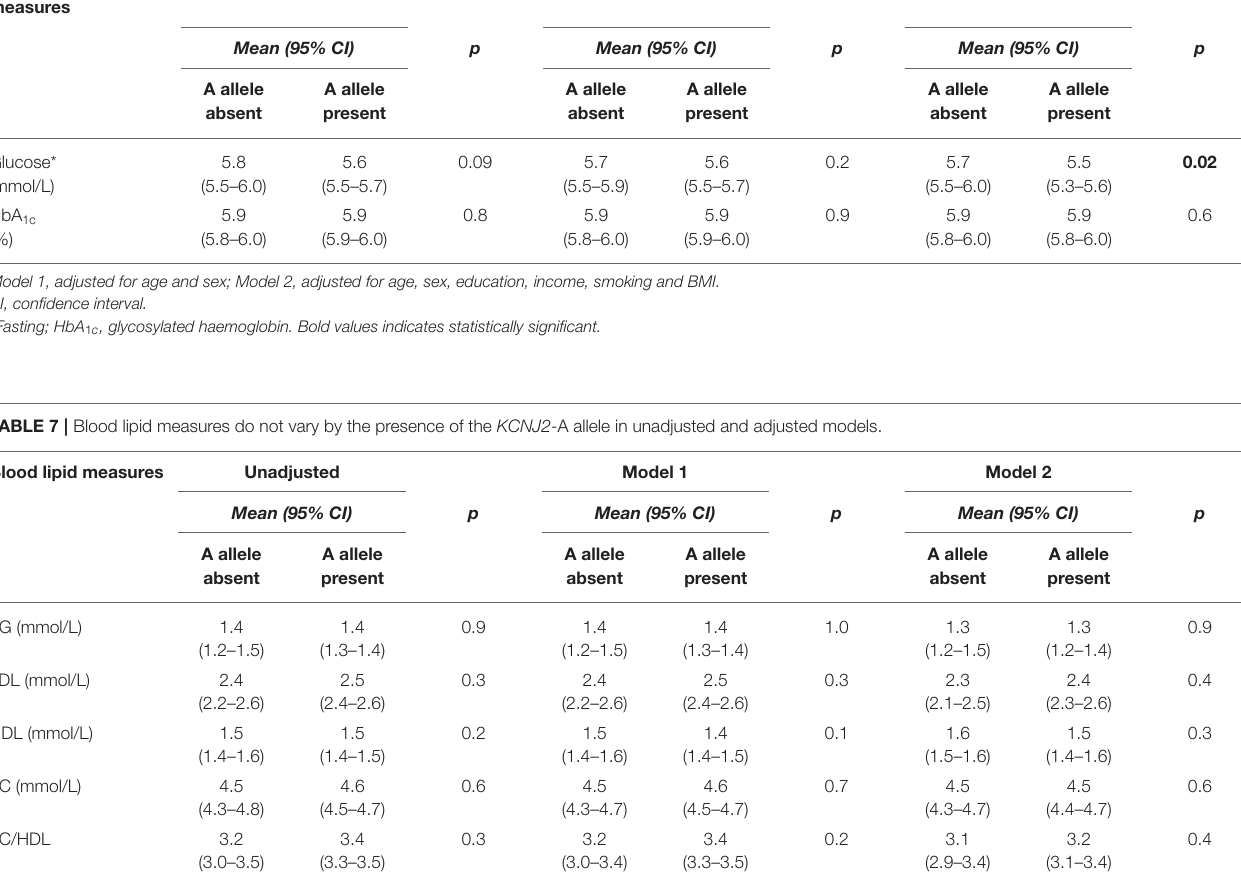
Unadjusted Model 1 Model 2 Mean (95% CI) p A allele A allele absent present